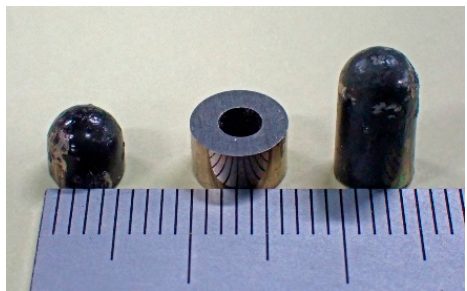
Figure 24. Three different specimens used for the third